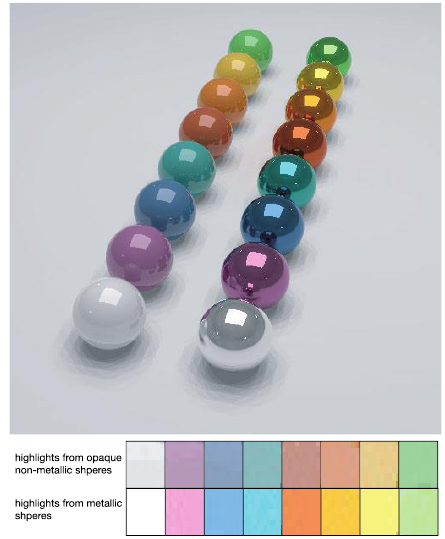
Figure 2. Image of spheres modeled and rendered with the RADIANCE software, showing the colors of highlights present in non-metallic and metallic materials with the same spectral reflectance.